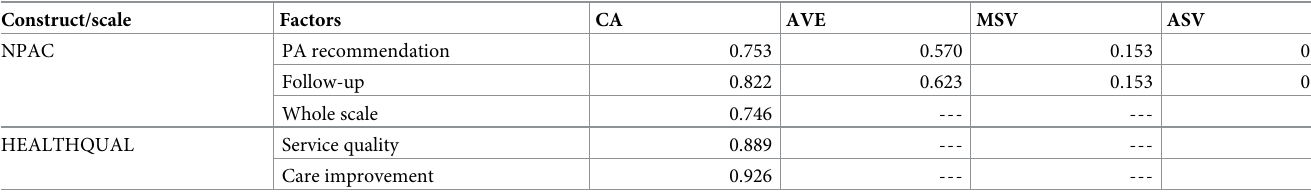
Table 1. Psychometric indicators of the NPAC